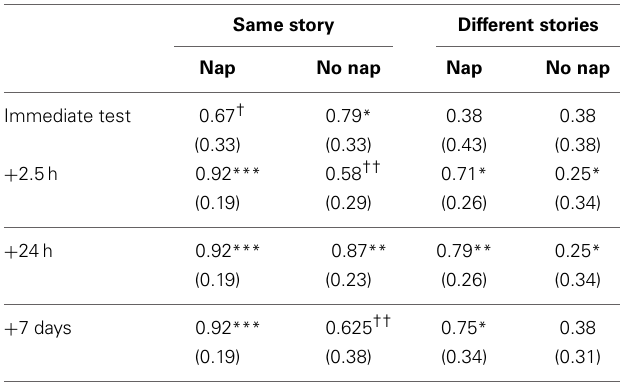
Table 2 | Children’s responses on word learning trials with the other target as a